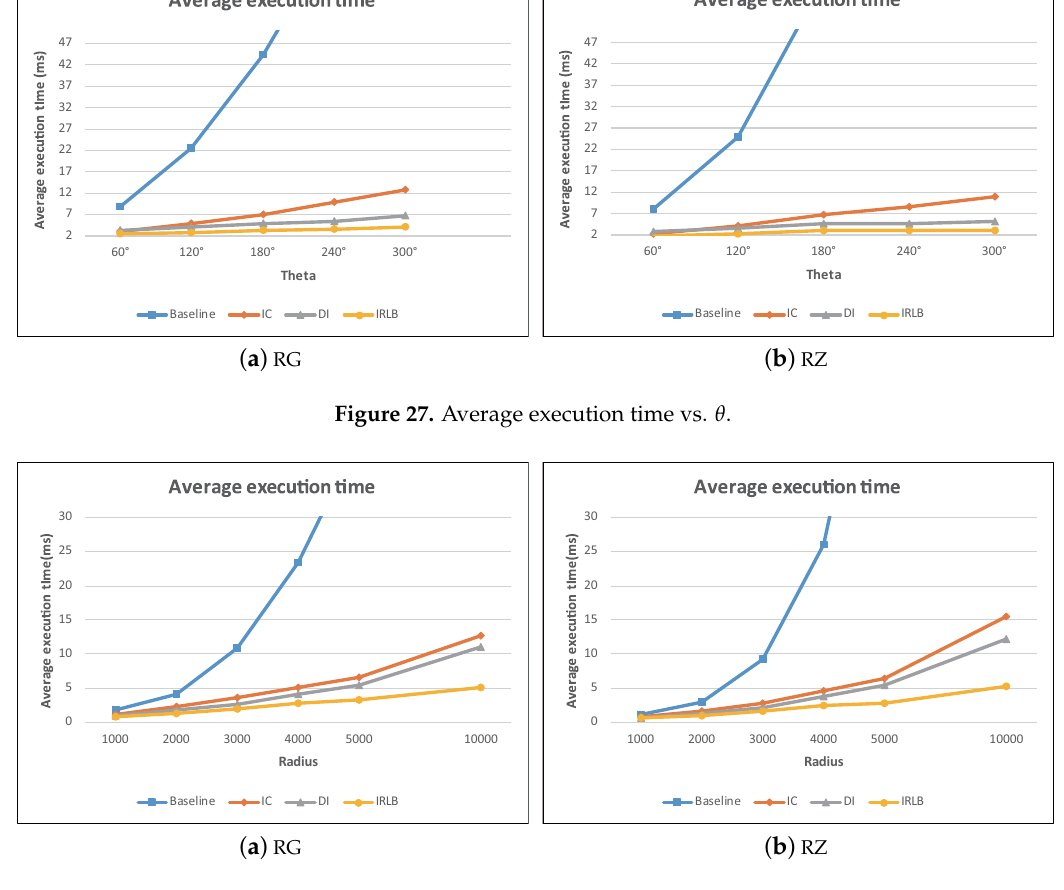
Figure 28. Average execution time vs. r